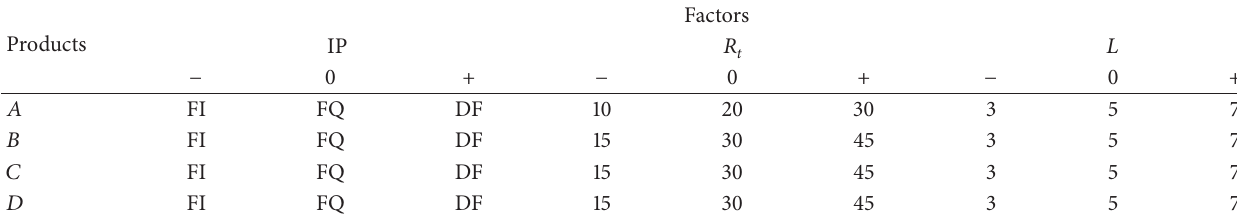
Table 2: DOE configuration.